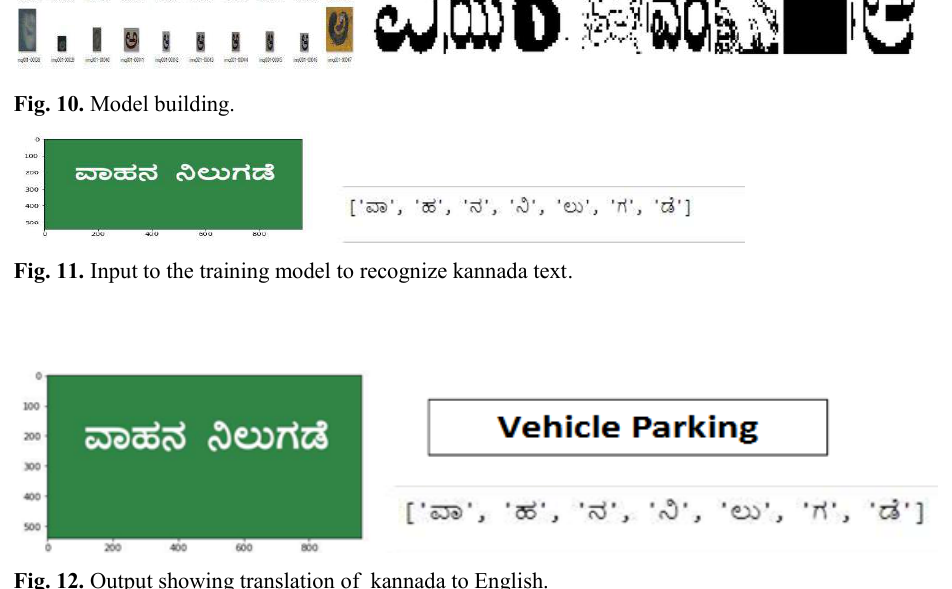
Fig. 12. Output showing translation of kannada to